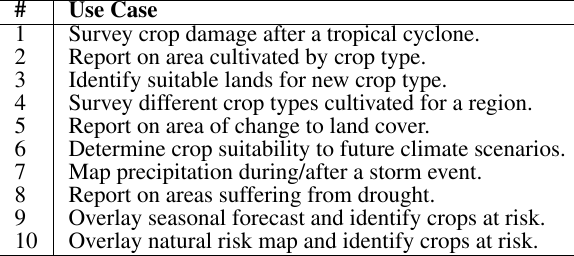
Table 2. The set of use cases derived and refined by collaboration with potential users.